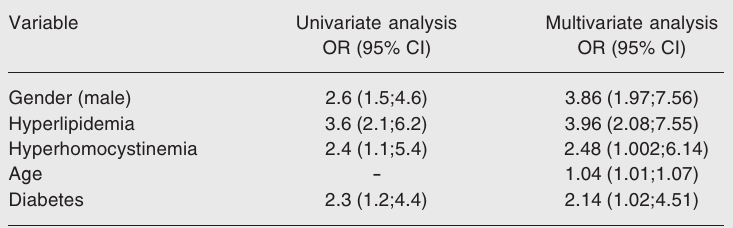
Table 2. Variables independently associated with coronary artery disease (CAD) after stepwise multiple regression